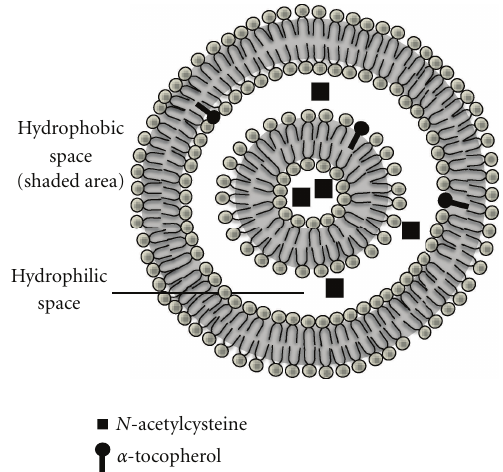
Figure 1: Schematic representation of a liposome containing antioxidants. Liposomes are artificially prepared vesicles made of lipid bilayer. Water-soluble compounds (e.g., N-acetylcysteine (NAC)) can be encapsulated in the aqueous phase, while lipid- soluble compounds (e.g., α -tocopherol) can be incorporated into the lipid bilayer of the